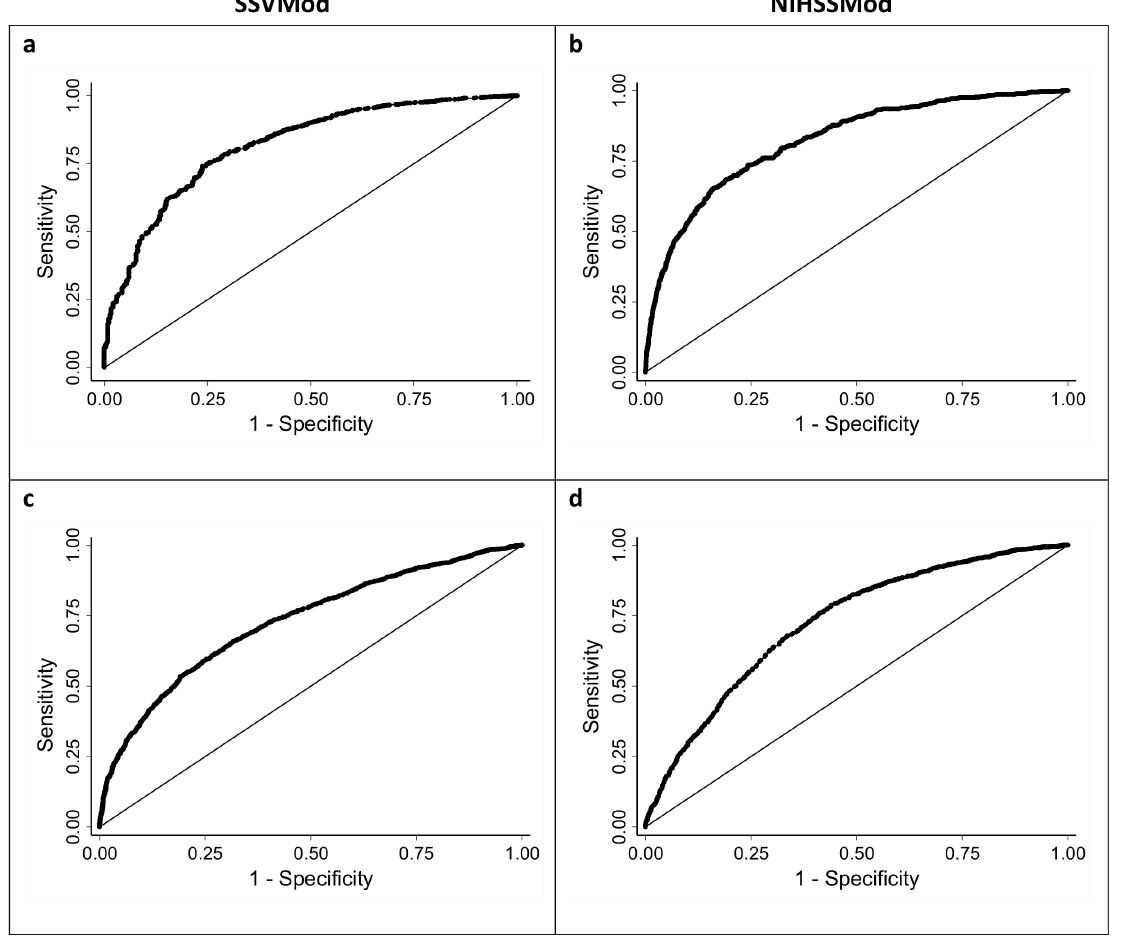
Fig 1. Receiver operating characteristics (ROC) curves for survival and independence, for the total sample. Optimally, the curve should lie towards the upper left corner of the plot. Survival: assessed at 30 days for the SSVMod and at 100 days for the NIHSSMod. Independence: assessed at 6 months for the SSVMod and at 3 months for the